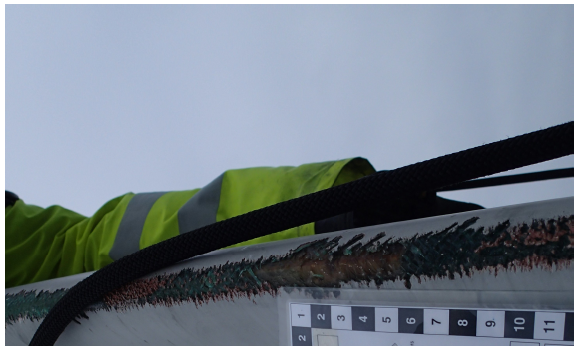
Figure 2. Erosion on a real rotor blade on a near-shore wind turbine after approx. one year of operation (courtesy of Blade Repair Solutions).